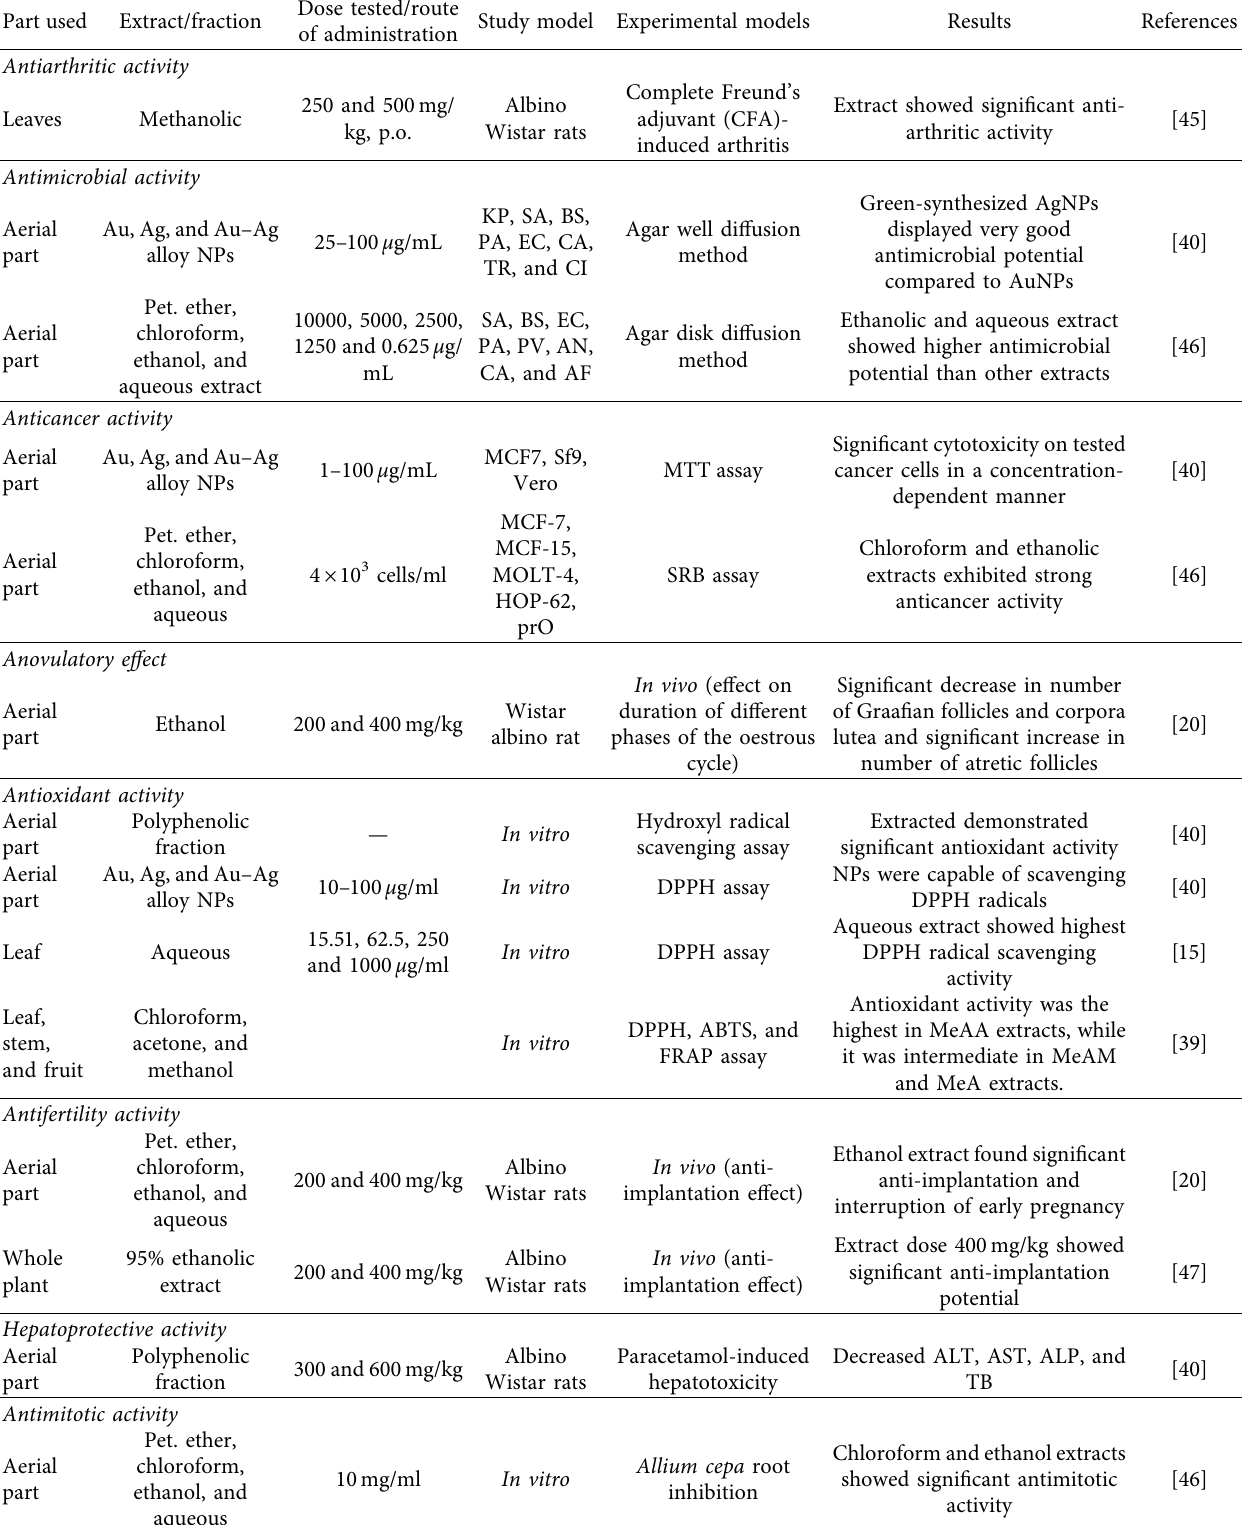
Table 3: Biological activities of R. hypocrateriformis